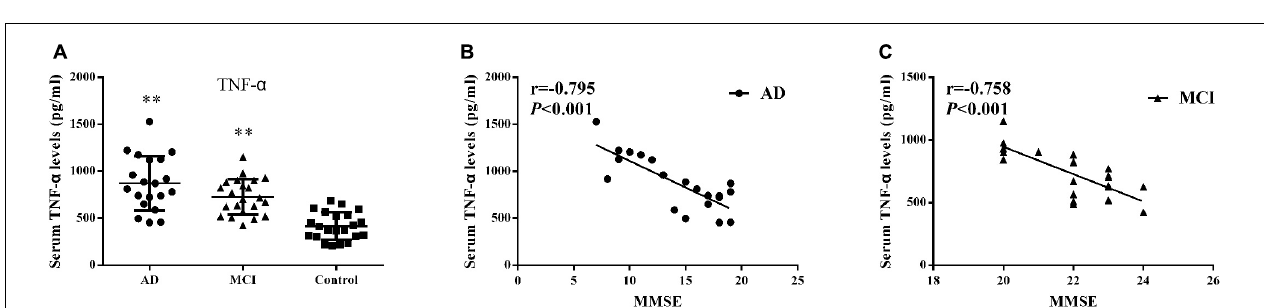
FIGURE 3 | Serum TNF- α (A) Concentrations of TNF- α in AD patients, MCI patients and controls. Bar graphs represent the mean ± SD, ∗∗ P ≤ 0.01 versus controls. Correlations between serum TNF- α levels and the MMSE scores in (B) AD and (C) MCI patients.